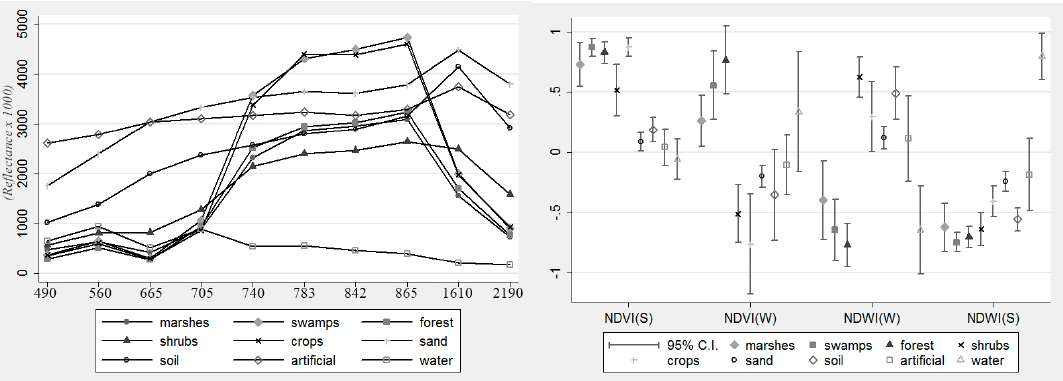
Figure 2. Spectral signatures of selected land use/land cover (LULC) classes ( left ). Vertical and horizontal axis represents the reflectance values (multiplied with scale factor of 10,000) of the Sentinel 2 summer image and the spectral bands used in this study in nanometers, respectively. Spectral mean values for Normalized Difference Vegetation Index (NDVI) and Normalized Difference Water Index (NDWI). Vertical axis represents the index values ( right ). The chart shows the values for the summer image (2 August 2016).